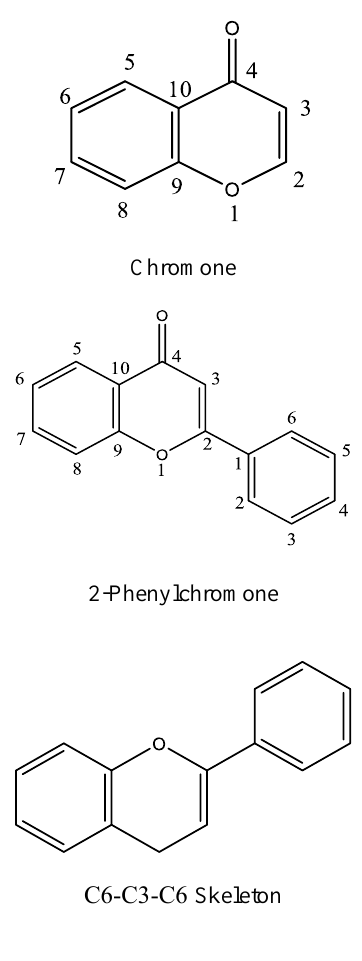
Figure 2 . Basic structure of Flavonoids